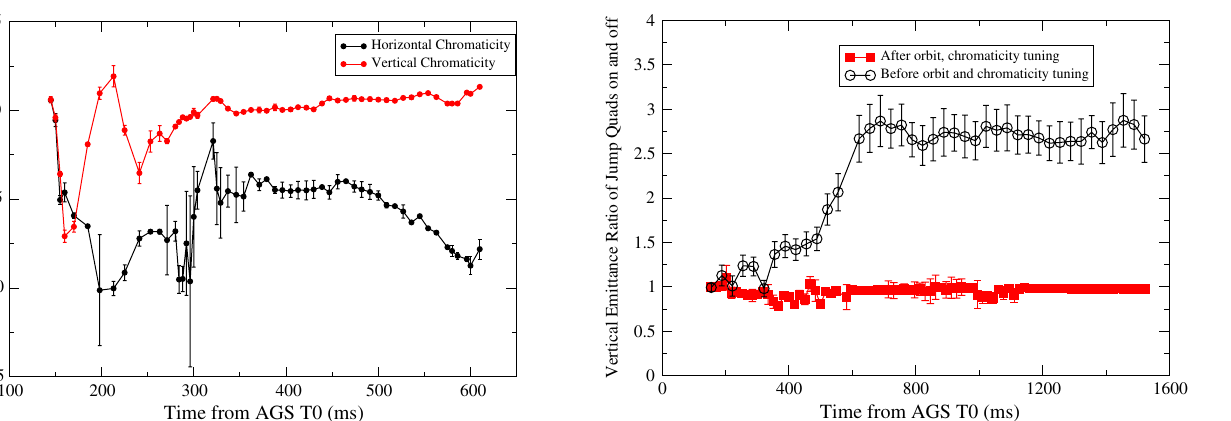
FIG. 4. The measured chromaticities of AGS. The proper values are needed to reduce tune spread and preserve emittance during horizontal tune jump.